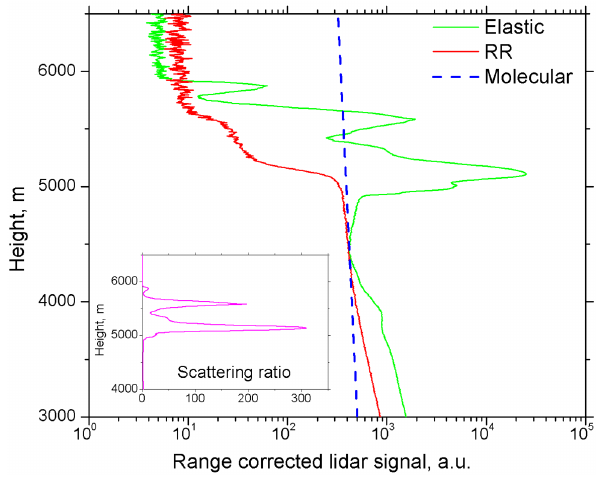
Figure 8. Range-corrected elastic 532nm and RR lidar signals in the presence of clouds. Model signal of molecular scattering is in- dicated by dash line, and the profile of scattering ratio is shown as an